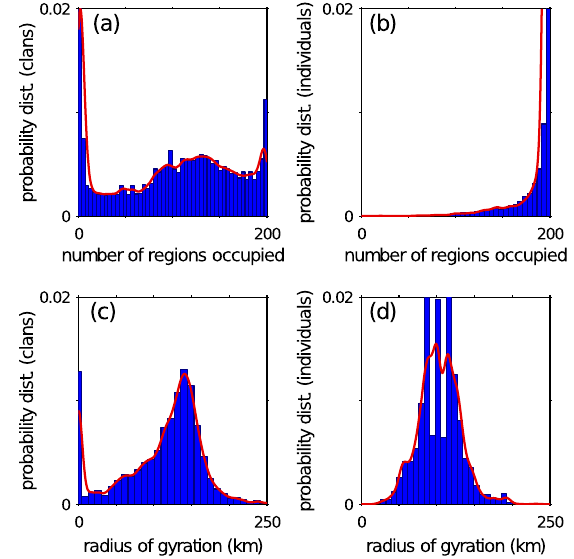
FIG. 3. Distribution of the number of different administrative regions occupied by clans. (a) Probability distribution of the number of different administrative regions occupied by a Korean clan in the year 2000. (b) Probability distribution of the number of different administrative regions occupied by the clan of a Korean individual selected uniformly at random in the year 2000. The difference between this panel and the previous one arises from the fact that clans with larger populations tend to occupy more administrative regions. [That is, we select a clan uniformly at random in panel (a), but we select an individual uniformly at random in panel (b).] Note that the rightmost bar has a height of 0.17, but we have truncated it for visual presentation. (c) Prob- ability distribution of radii of gyration (in km) for clans in 2000. (d) Probability distribution of radii of gyration (in km) for clans of a Korean individual selected uniformly at random in 2000. The difference between this panel and the previous one arises from the fact that clans with larger populations tend to occupy more administrative regions. Solid curves are kernel density estimates (from M ATLAB R2011a ’ s KSDENSITY function with a Gaussian smoothing kernel of width 5).